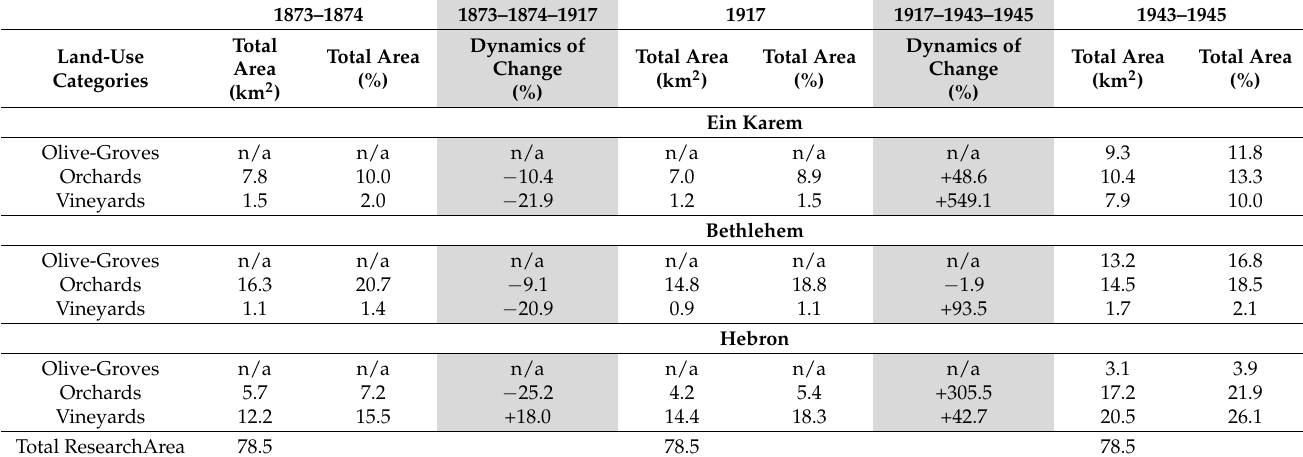
Figure 3. Changes in agricultural land-use in the research areas. The figure is divided into the three research areas, Ein Karem, Bethlehem and Hebron, and each one is divided into the three time periods, 1873–1874, 1917, and 1943–1945. Land uses are divided into four categories—built-up areas, olive groves, orchards, and vineyards. Table 2. Agricultural land-use changes in the research areas (Ein Karem, Bethlehem, and Hebron) for each period examined, 1873–1874, 1917, and 1943–1945. The total area for each category is presented both in square kilometers and percentage of the total research area. Additionally, the dynamic percentage of land use changes in each category is presented for the periods between 1873–1874–1917 and 1917–1943–1945.